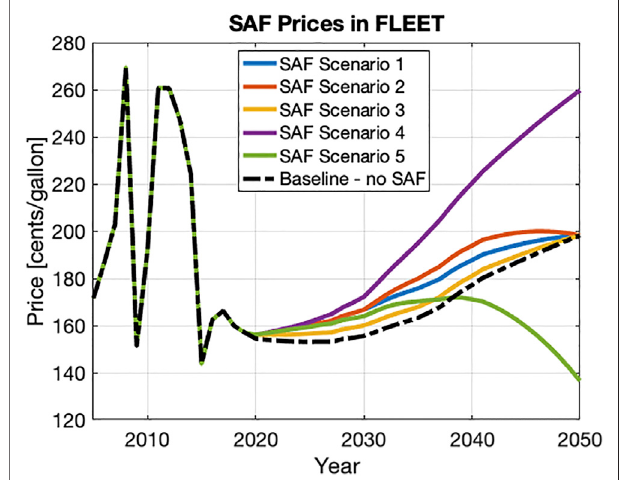
FIGURE 4 | SAF prices in FLEET for all future